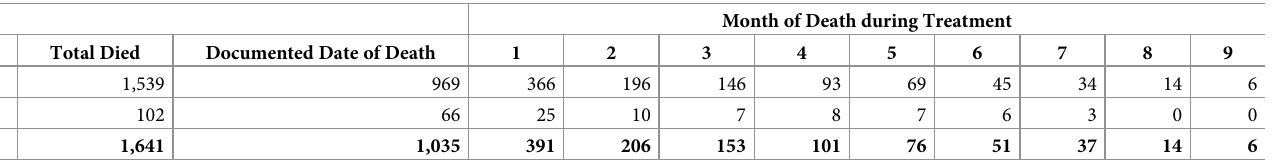
Table 3. Time of death during treatment.